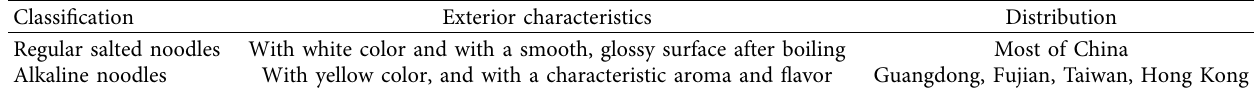
Table 5: Appearance and distribution of different noodles.